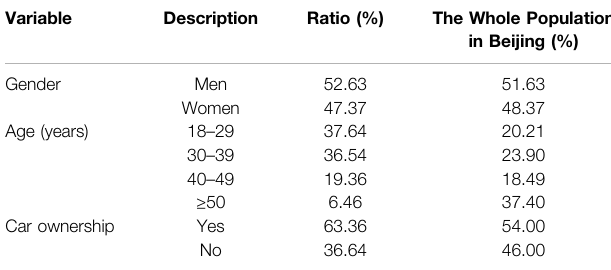
TABLE 2 | Summary statistics of